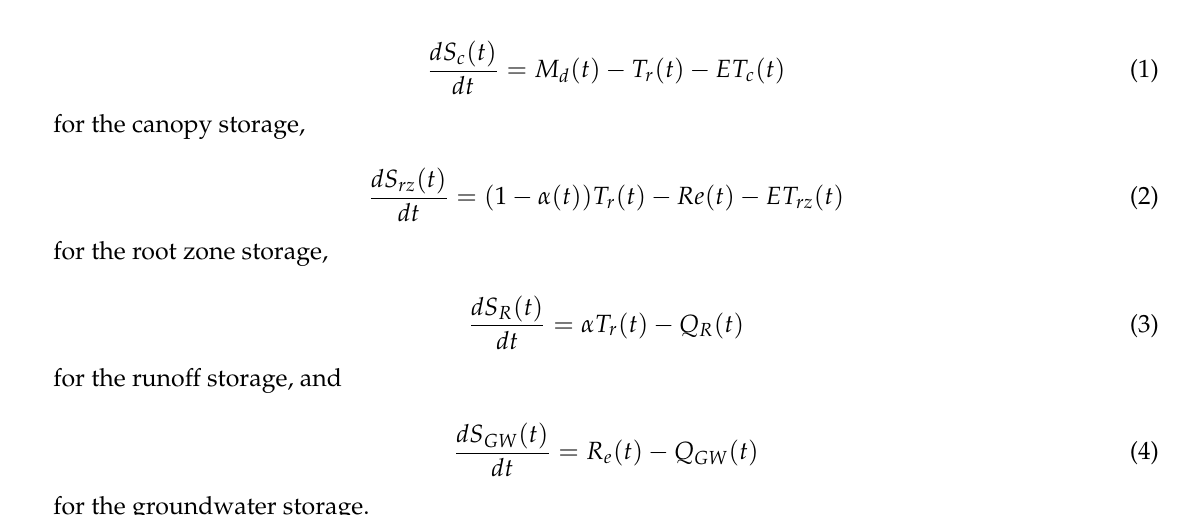
Table 2, the so-called expressions table, provides mathematical completeness to the fluxes. Table 2. Table of associations between fluxes and expressions related to the